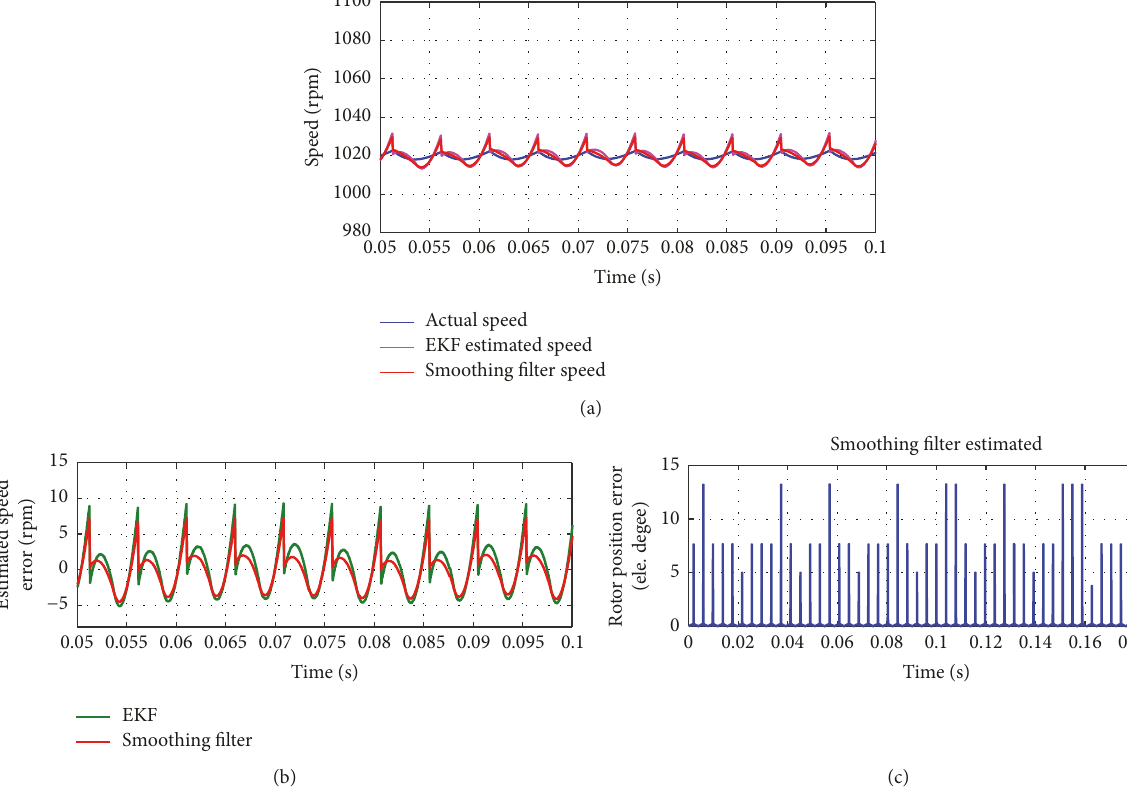
Figure 8: (a) Speed estimation at no load. (b) Speed estimation error. (c) Position estimation error with smoothing